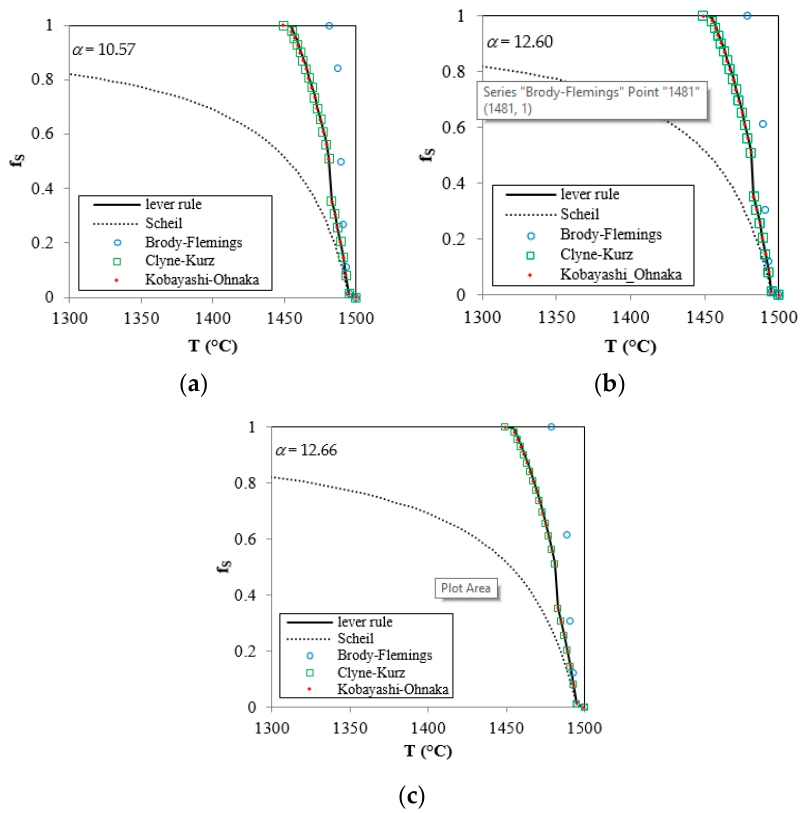
Figure 4. Predicted solid fraction / temperature curves for the Regions 1–3 according to the classical limiting cases and the intermediate models over a range of Fourier number values: ( a ) α = 10.57 (ingot wall side); ( b ) α = 12.60 (mid-radius region); ( c ) α = 12.66 (ingot center).